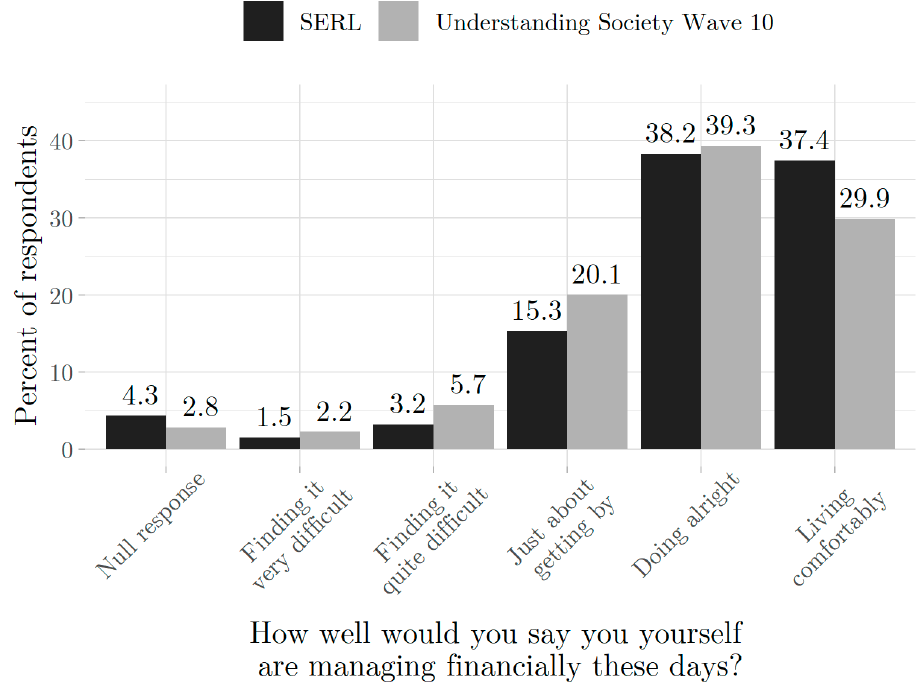
Figure 11. SERL Observatory responses to question D4 about financially wellbeing, compared to Understanding Society Wave 10.